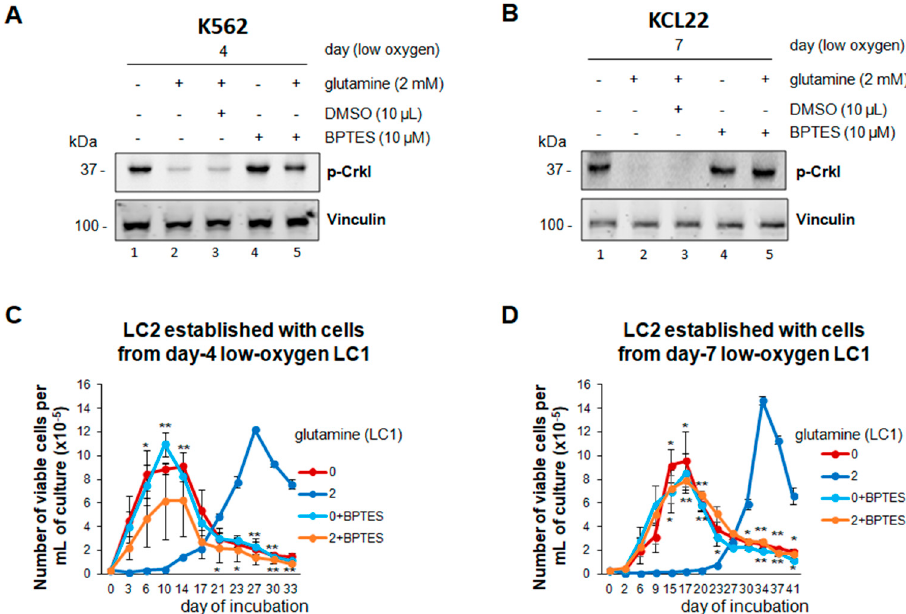
Figure 7. Effects of BPTES on BCR/Abl signaling and maintenance of stem cell potential in low oxygen in the absence or the presence of glutamine. K562 ( A , C ) or KCL22 ( B , D ) cells were seeded at 3 × 10 5 cells/mL and incubated in atmosphere at 0.2% O 2 for 4 or 7 days, respectively, in the absence (0/ − ) or the presence (2/+) of 2 mM glutamine and with or without ( − /+) 10 µ M BPTES ( A – D ) or its solvent DMSO (A, B) added at time 0 of incubation. ( A , B ) Total cell lysates in Laemmli buffer were subjected to SDS-PAGE and immuno-blotting with anti-p-Crkl Ab or anti-vinculin Ab, used to verify equalization of protein loading. One representative experiment out of 3 with similar results is shown. ( C , D ) LC1 cells were transferred at 3 × 10 4 cells/mL into drug-free LC2 incubated at 21% O 2 and in any case in the presence of glutamine. Trypan blue-negative cells were counted at the times of incubation in LC2 indicated in abscissa. Values are mean ± S.D. of data obtained from 3 independent experiments; * p < 0.05, ** p < 0.01 vs. 2 mM glutamine/no drug. The original Western blotting images and the relative densitometry values can be found in Supplementary Figure